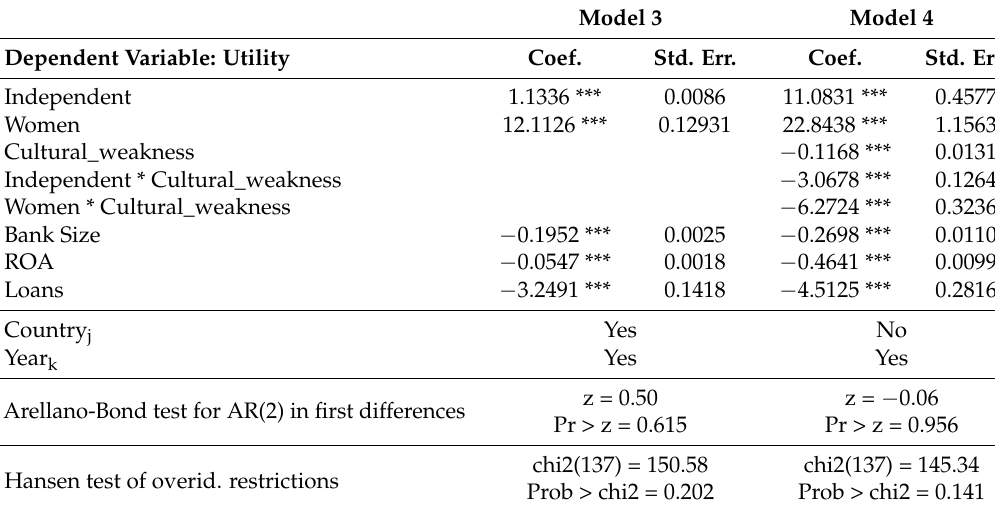
Table 7. Effect of independence and diversity of the board on Utility.